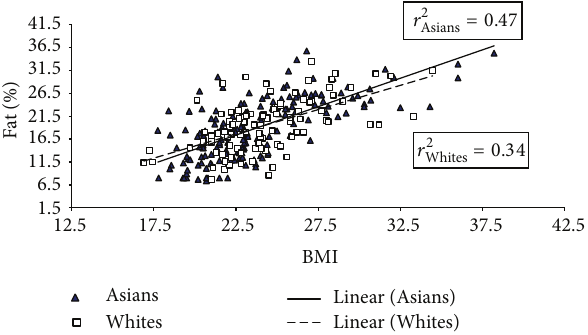
Figure 2: Distribution of body-mass index and percentage body fat for females according to